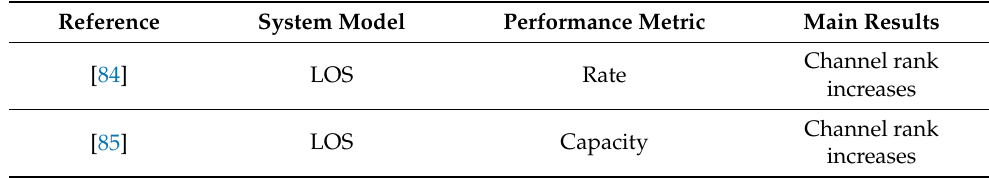
Table 5. Single-user MIMO